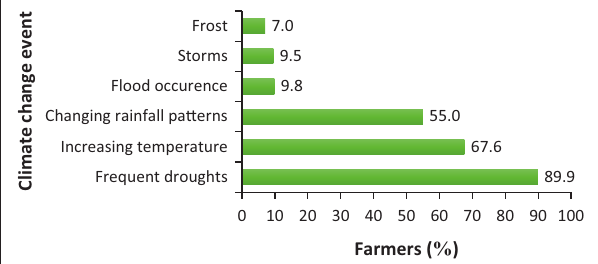
FIGURE 3: Common climate change events experienced by smallholder farmers.